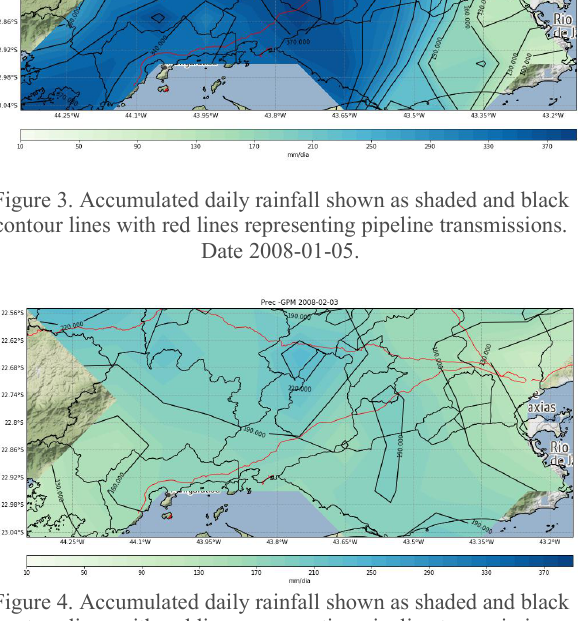
Figure 4. Accumulated daily rainfall shown as shaded and black contour lines with red lines representing pipeline